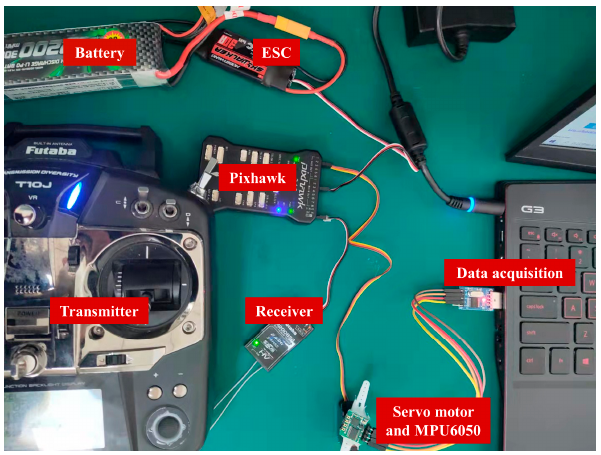
Figure 15. Measurement set-up for servo motor data acquisition. Figure 16 represents the transient state response of the rotation angle of the servo motor with a step input. The transfer function of the servo motor adopted in terms of the natural frequency and damping is shown in Equation (17).